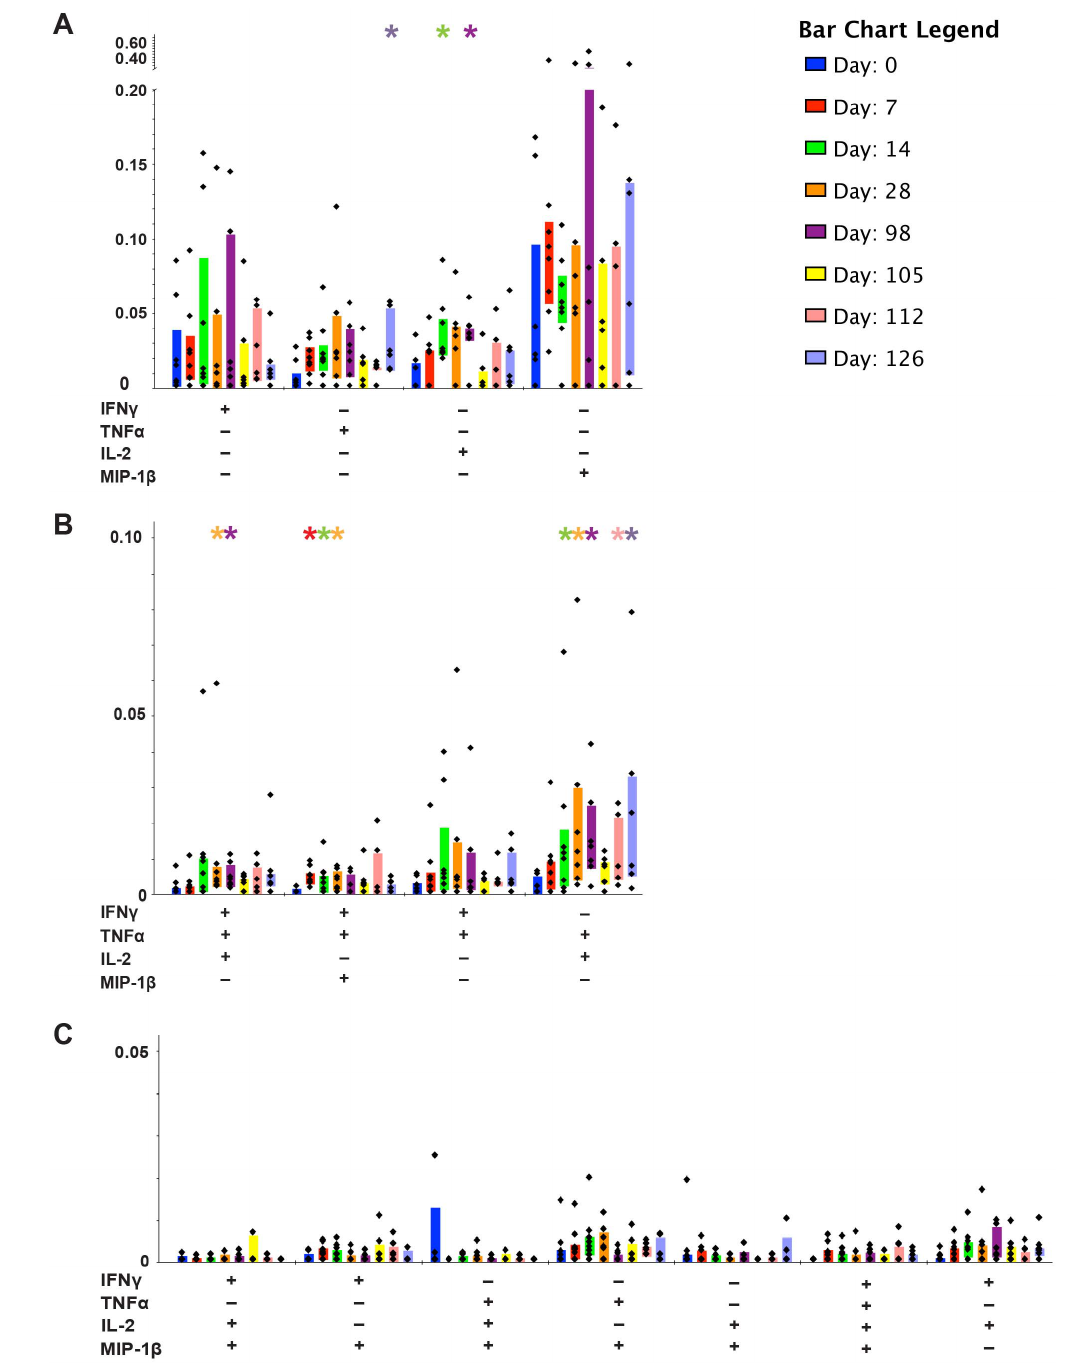
Figure 3. Monofunctional CD4 + T cells from naı¨ve and veterans post C.jejuni exposure are dominant over multifunctional cells. The kinetics of T cell responses are shown, separating CD4 + phenotypes based on the combinations of cytokines they produced (designated by + /-) under the x-axis. X-axis shows the combinations of IFN c , TNF a , IL-2, and MIP-1 b producing cells. Each colored bar designates the interquartile range (IQR). Days evaluated include: D0, D7, D14, D28, D98, D105, D112, and D126. A) Monofunctional CD4 + phenotypes. B and C) Multifunctional CD4 + phenotypes relative to D0. Statistically significant days are relative to D0 (Wilcoxon ranked test) and P # 0.05 is designated by ‘‘ * ’’.